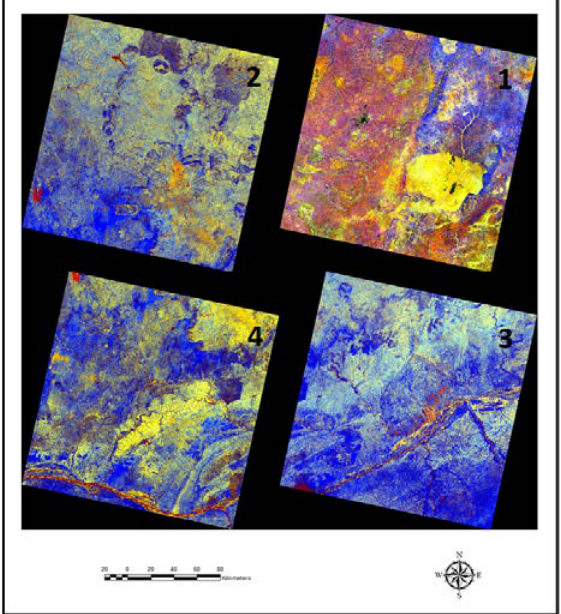
Figure 3. Colour Composites of scenes one, two, three and